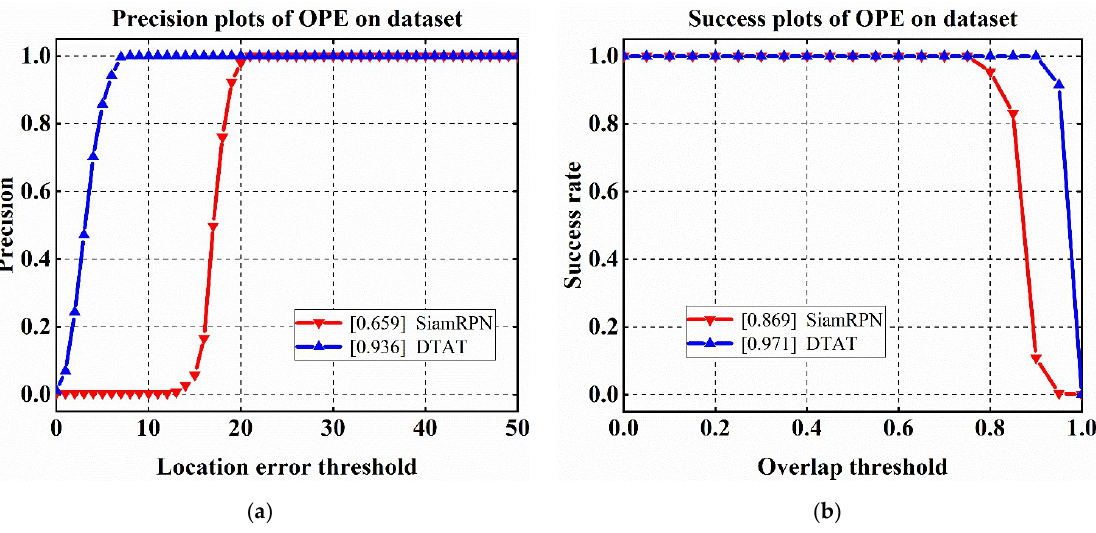
Figure 9. Performance comparison of tracking algorithms: ( a ) OPE accuracy; and ( b ) OPE success rate.